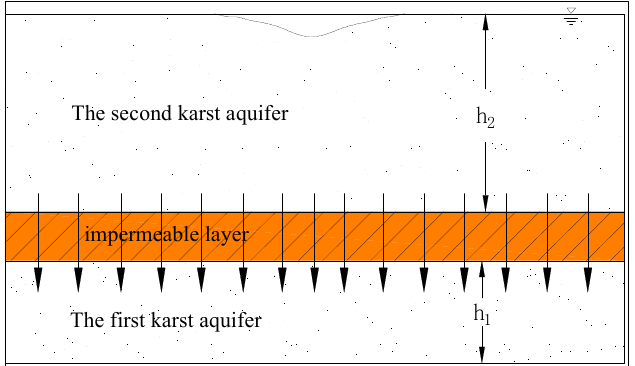
Figure 11. Leakage recharge model of multi-aquifer in Daojiao coal